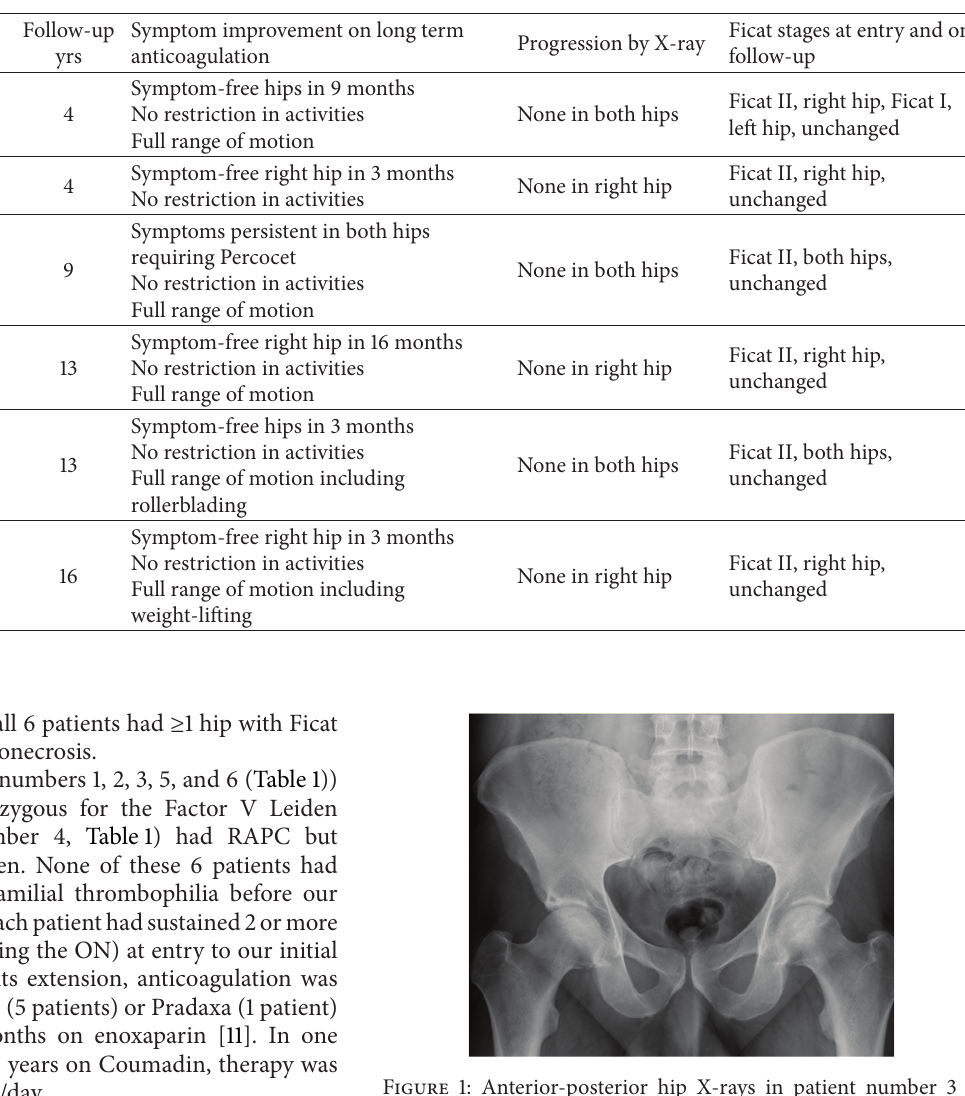
Table 1: Six patients, 9 hips (5 heterozygous for the V Leiden mutation, 1 with resistance to activated protein C). Anticoagulation for 4 to 16 years. Symptoms, nonprogression by X-ray, and Ficat stages at entry and on follow-up.